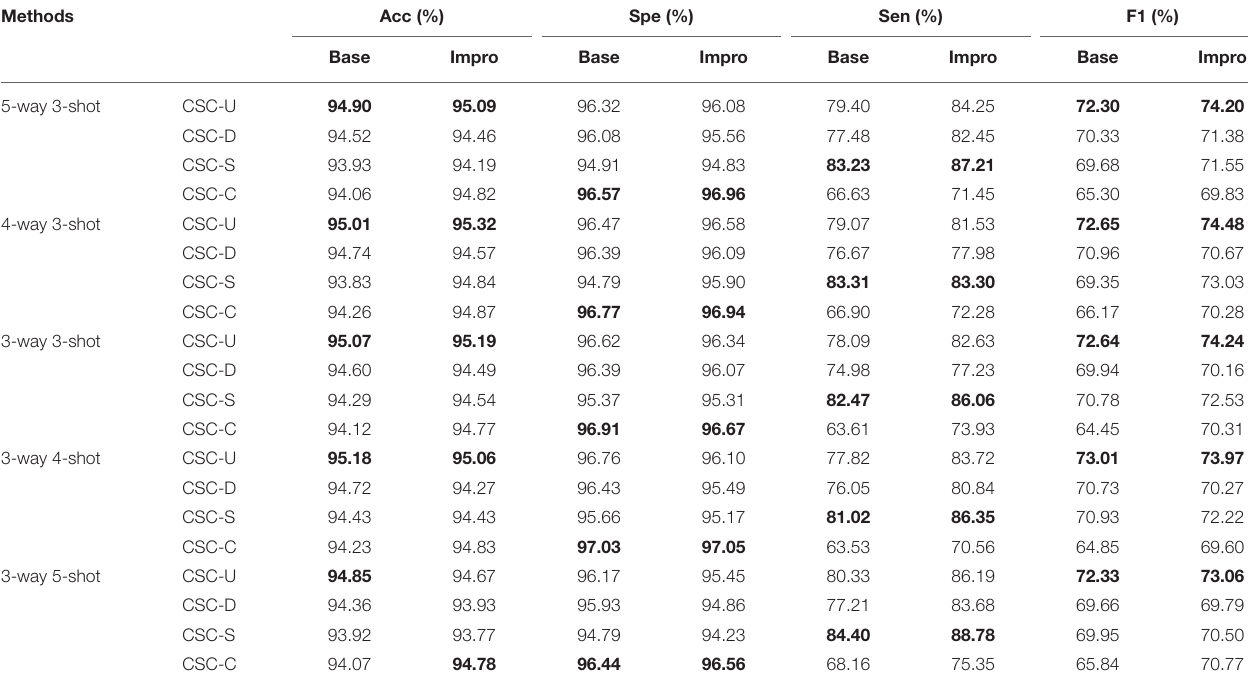
The bold values indicate the maximum value of the corresponding metric in the